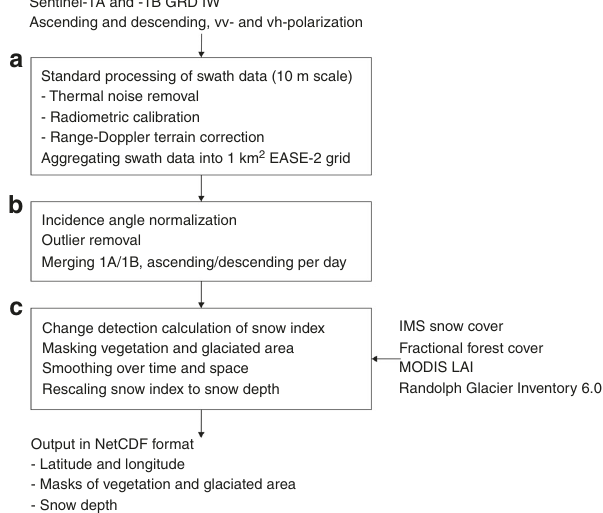
Fig. 2 Flowchart of the Sentinel-1 processing. a The standard backscatter processing techniques are performed using the Google Earth Engine Python ’ s api. b Further processing steps, and c the application of the retrieval algorithm are performed of fl